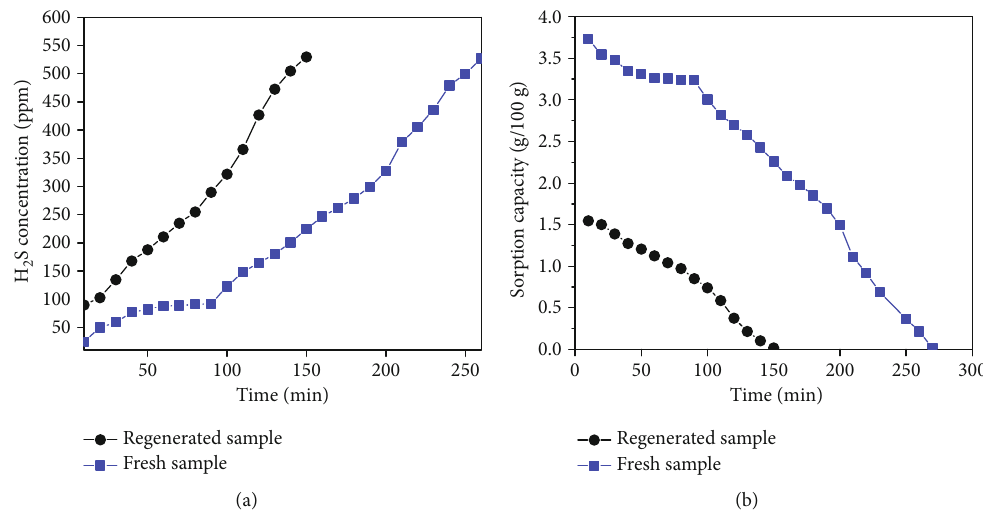
Figure 10: Comparison between the fresh sample and regenerated sample: (a) H sorption capacity. Test conditions: T